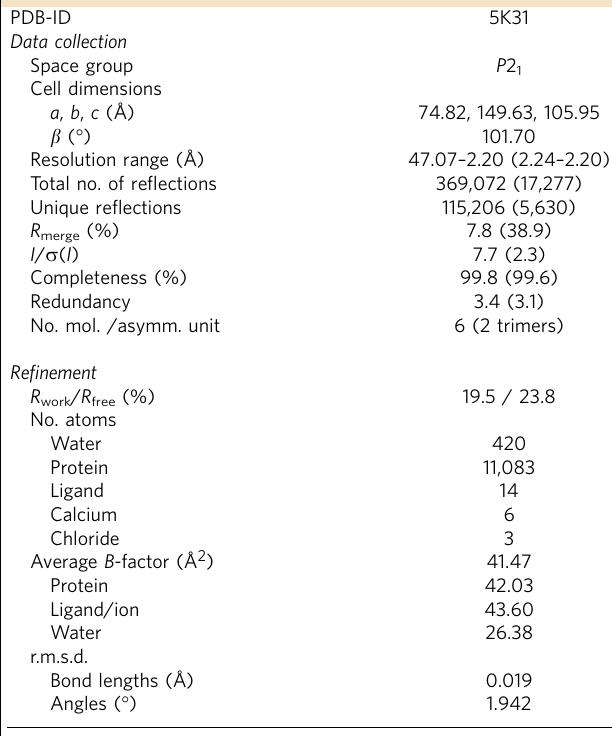
Table 1 | Data collection and refinement